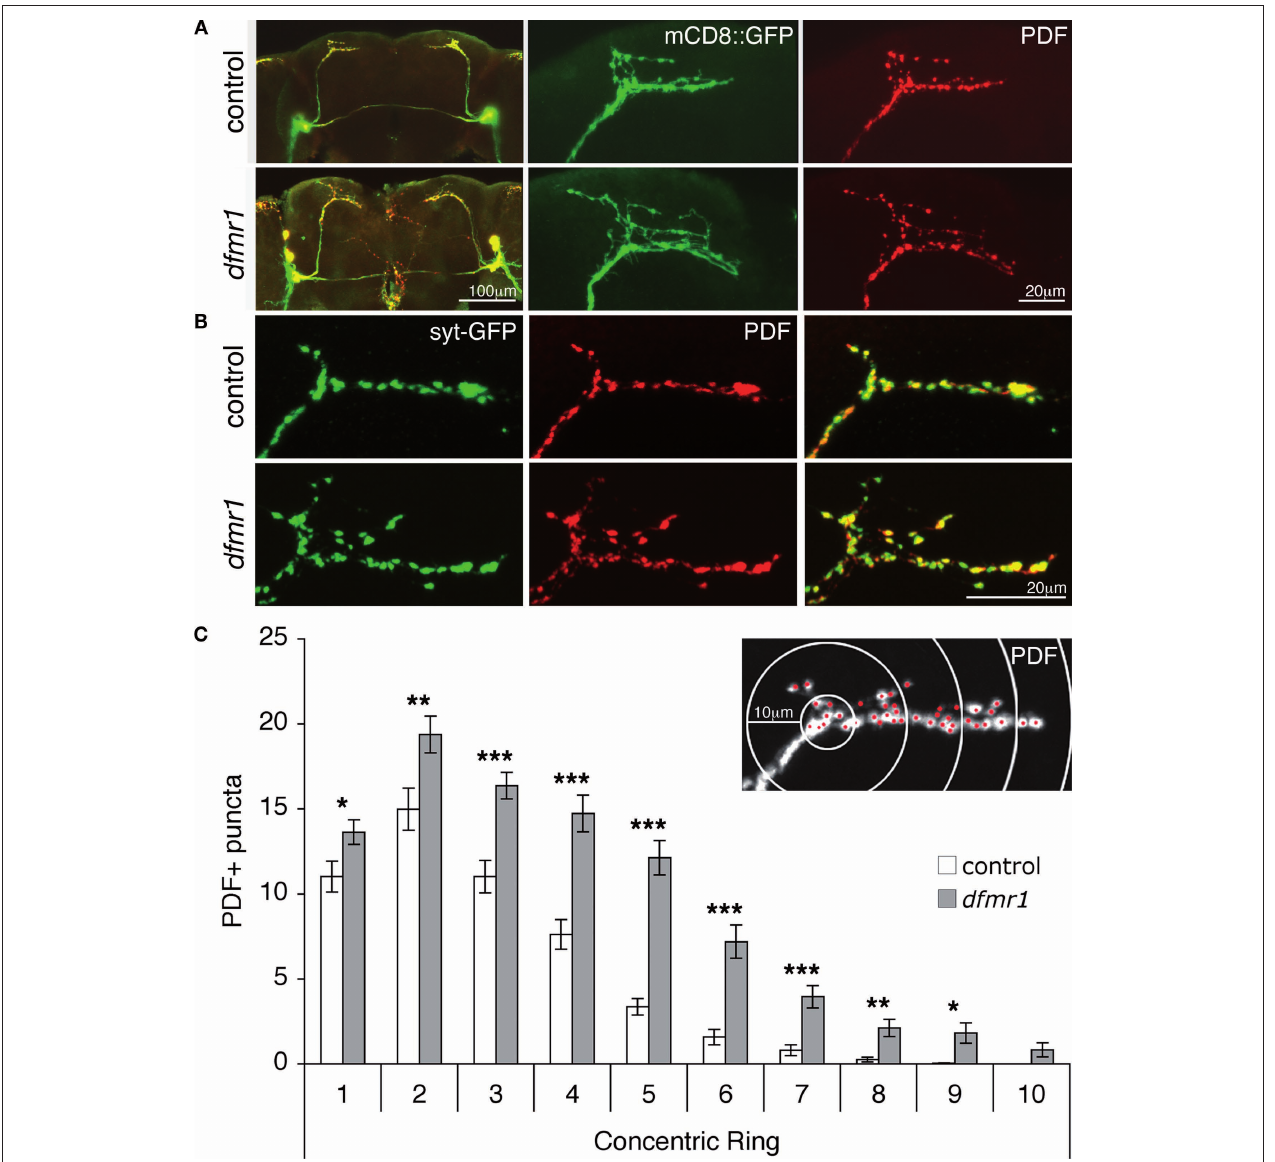
FIGURE 1 | sLN synaptic architecture defects in the absence of dFMRP. v (A) Representative images of adult Drosophila brains isolated from animals expressing a UAS-mCD8::GFP (green) transgene under the control of the ventrolateral neuron (LN ) specifi c PDF-GAL4 driver in both genetic background v control and homozygous dfmr1 50M null ( dfmr1 ) mutants. Co- immunohistochemistry was done for the LN neuropeptide PDF (red). At left, low v magnifi cation images show both the large LN axonal projections with the v established posterior optic tract connecting both hemispheres and the small LN (sLN ) axonal tracts that defasiculate and arborize in the protocerebrum. At right, v